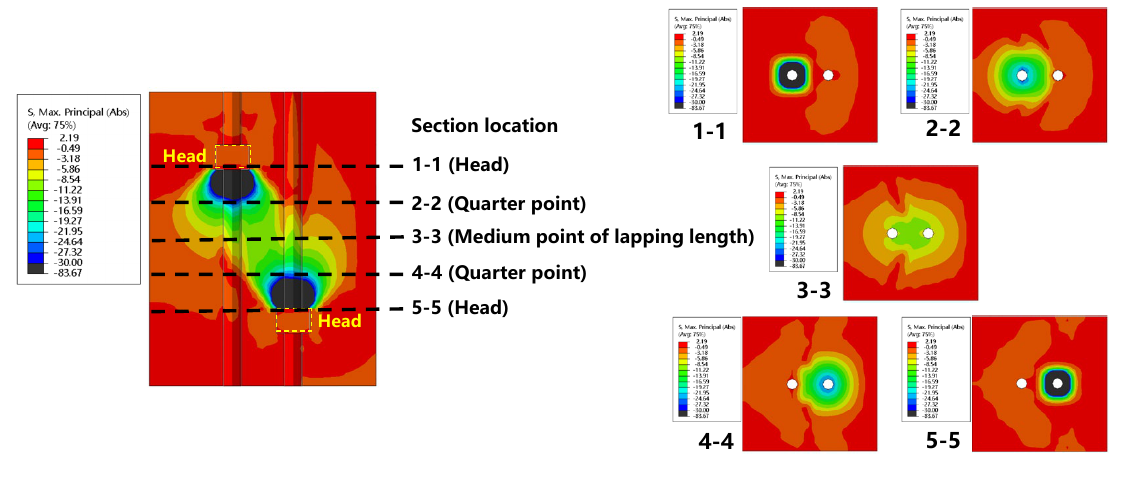
Figure 36. Stress contour at different level of height.